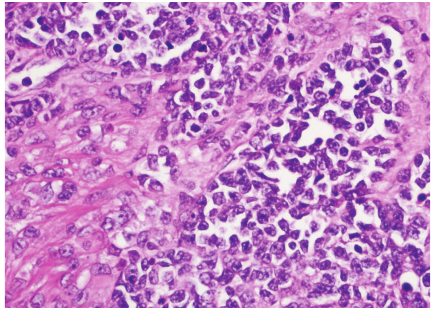
Figure 4: The small cell component was occasionally associated with a sclerotic stroma, ×